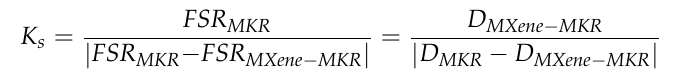
Figure 4. Experimental setup of photothermal fiber sensor based on MKR and MXene-MKR cas- cade.